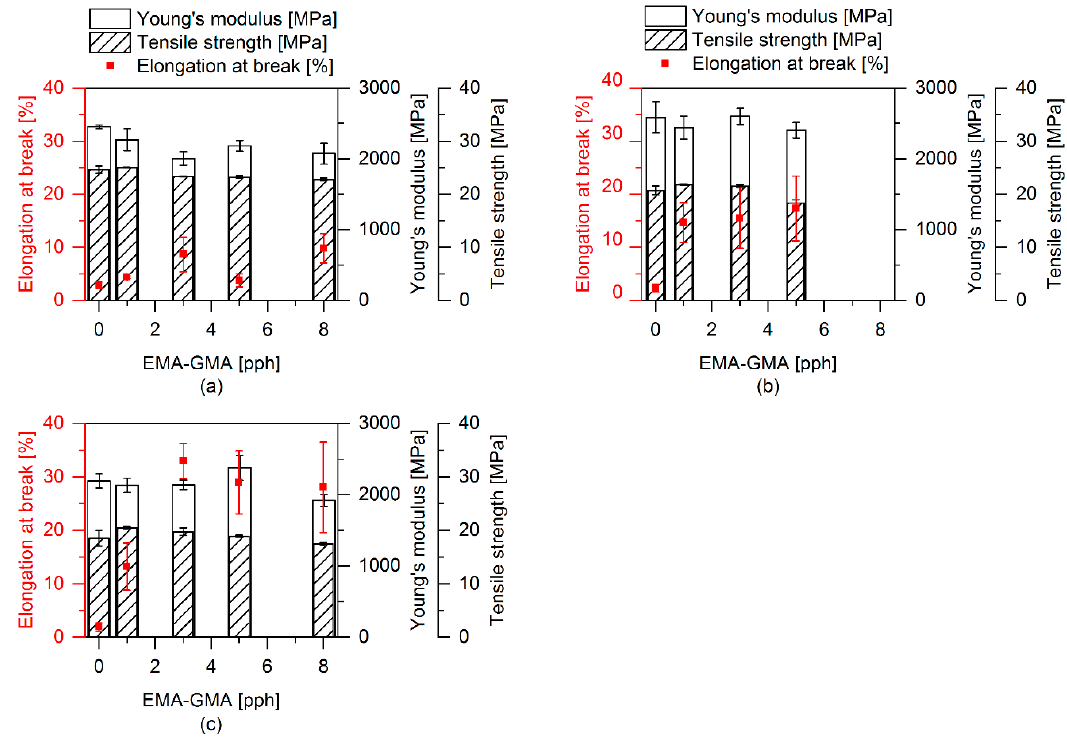
Figure 13. Tensile properties with varying ratios of EMAGMA. Each sample contains 20 pph of soft phase. ( a ) Samples without SBO and TBEC, ( b ) samples with 20 wt % SBO inside the soft phase, and ( c ) samples with 20 wt % SBO inside the soft phase and 0.2 pph TBEC.